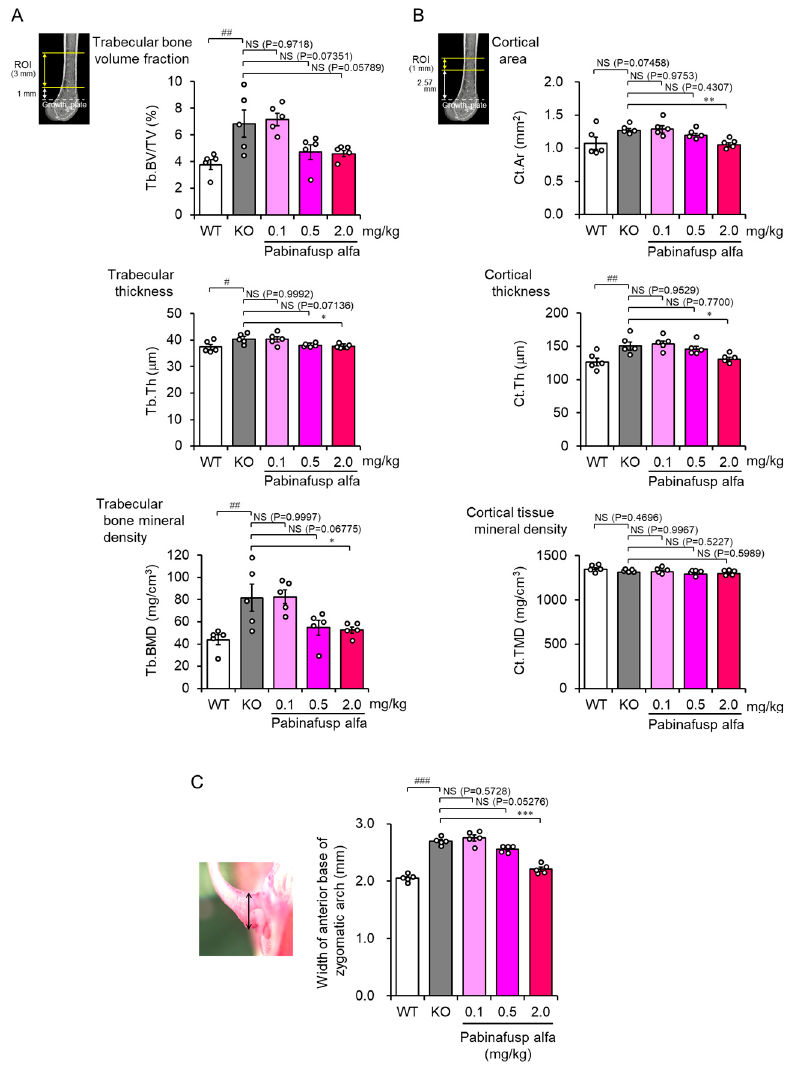
Figure 4. Correction of femoral and facial bone abnormalities in mucopolysaccharidosis (MPS) II mice after a 36-week treatment with pabinafusp alfa. ( A , B ) Three-dimensional X-ray micro-computed tomography imaging analysis was performed to measure bone morphological parameters of the trabecular ( A ) and cortical ( B ) bones of the femur. The top images present the regions of interest for the analysis. ( C ) Mice skulls were exposed after removing the scalp and immersed in 70% ethanol for a few days. After cleaning the remaining scalp, the width of the anterior base of the zygomatic arch (double-headed arrow in the photo on the left) was measured using a caliper. Bone samples obtained from a 36-week repeated dose study were analyzed [107] (our unpublished results). Values are mean ± SEM ( n = 5). # p < 0.05, ## p < 0.01, and ### p < 0.001, WT vs. KO; * p < 0.05, ** p < 0.01, and *** p < 0.001, KO vs. each treatment group (Dunnett’s test). NS, not significant; WT, wild-type mice; KO, vehicle-treated MPS II mice; Tb.BV/TV, trabecular bone volume fraction; Tb.Th, trabecular thickness; Tb.BMD, trabecular bone mineral density; Cr.Ar, cortical area; Cr.Th, cortical thickness; Cr.TMD, cortical tissue mineral density. retinal dysfunction in diabetes [71,72]. Retinopathy is also observed in patients with MPSs,